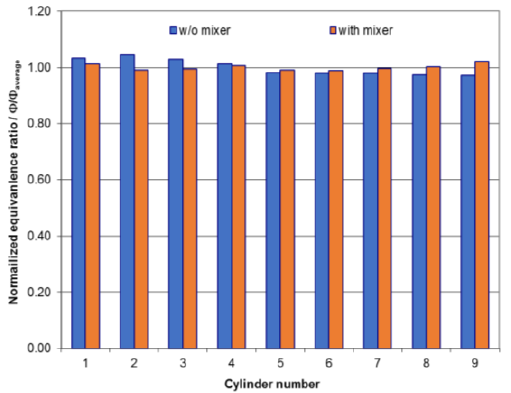
Fig. 3. Comparison of normalized equivalence ratio of two fuel system concepts for syngas relevant flow conditions COMBUSTION ENGINES, 2019, 179(4) 183